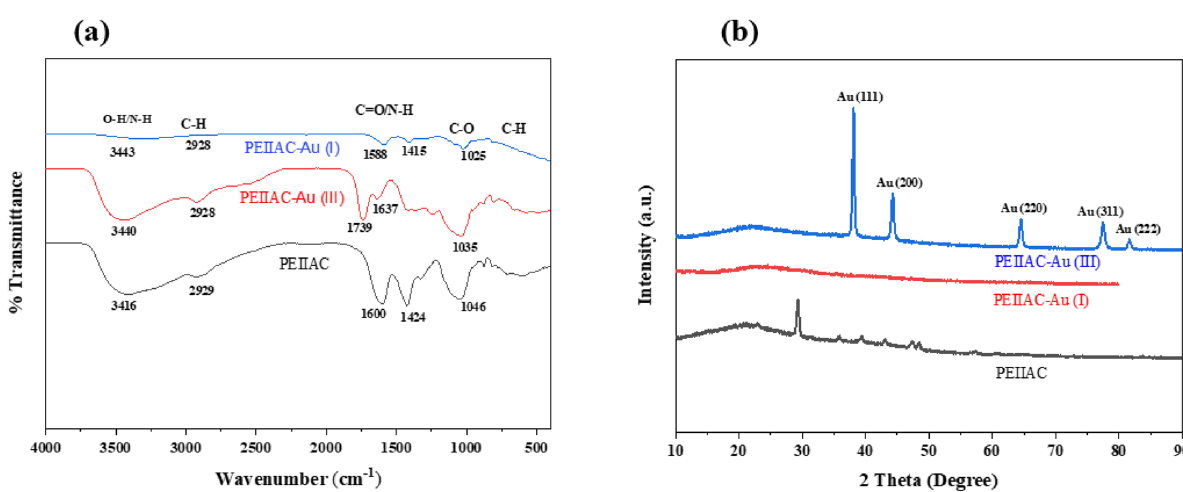
Figure 7. ( a ) FTIR and ( b ) PXRD patterns of PEIIAC before and after Au (III) and Au (I)